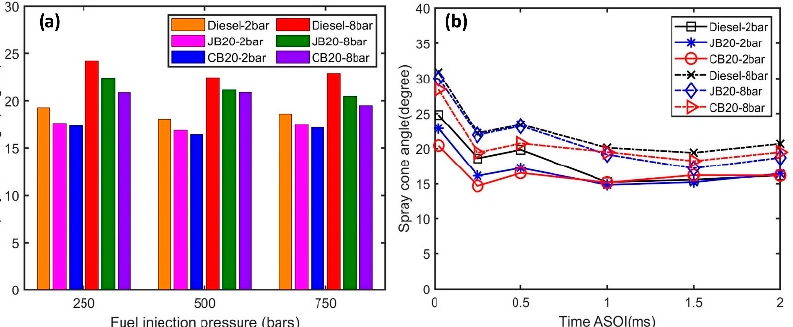
Figure 11. Experimental results for ( a ) SCA at three different injection and ambient pressures. ( b ) SCA with respect to time ASOI at 500 bar IP.